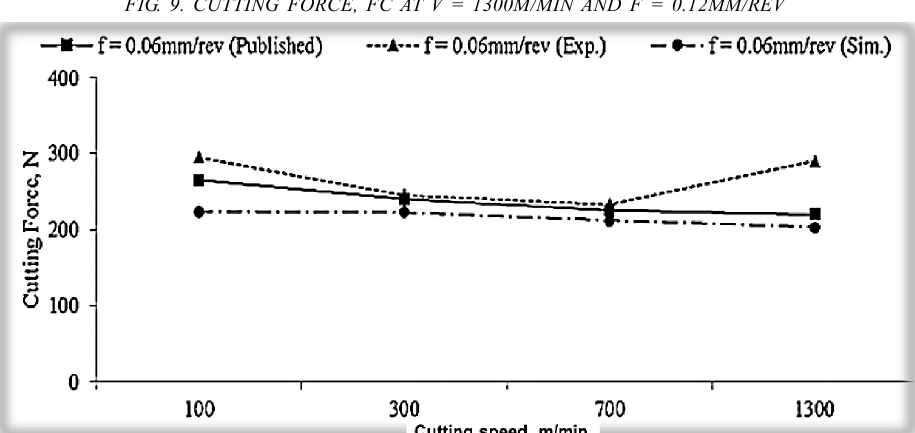
FIGURE 10. COMPARISON OF EXPERIMENTAL AND SIMULATED CUTTING FORCE, FC WITH THE PUBLISHED RESULTS AT THE FEED RATE, F = 0.06MM/REV